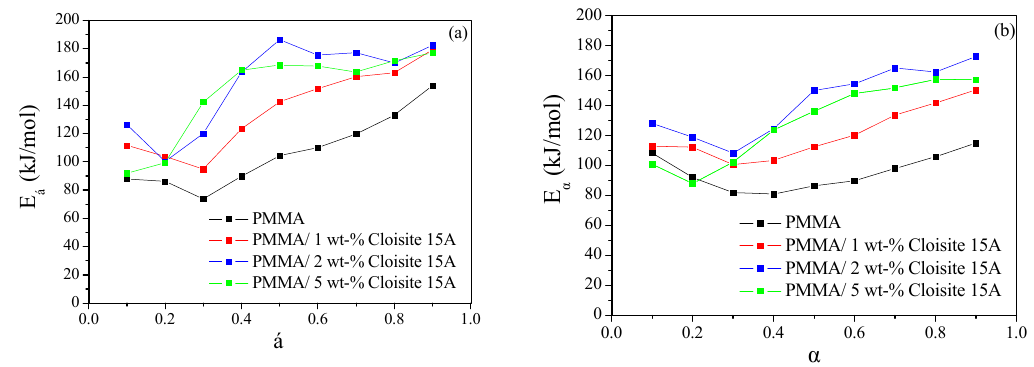
Figure 6. Effect of the OMMT clay content on the correlation between activation energy and the extent of thermal degradation for PMMA nanocomposites determined using the method of Friedman ( a ); and the method of Coats and Redfern ( b ).